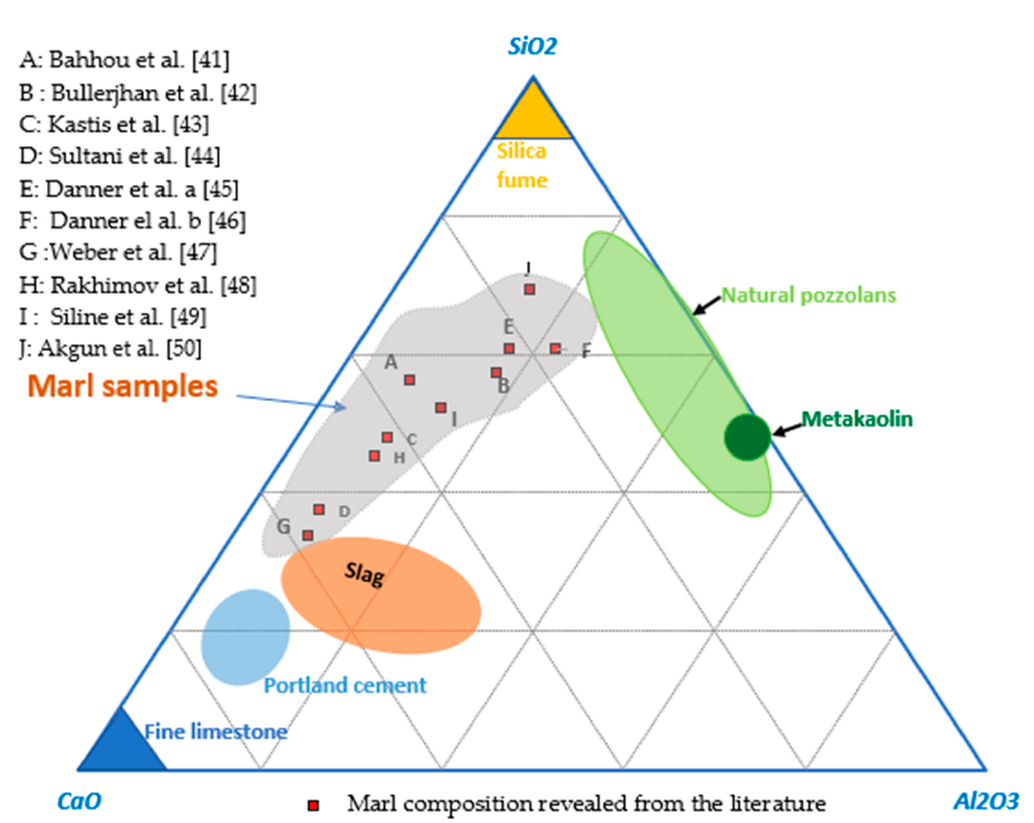
Figure 1. Conventional marls classification. Figure 1. C onventional marls classification.